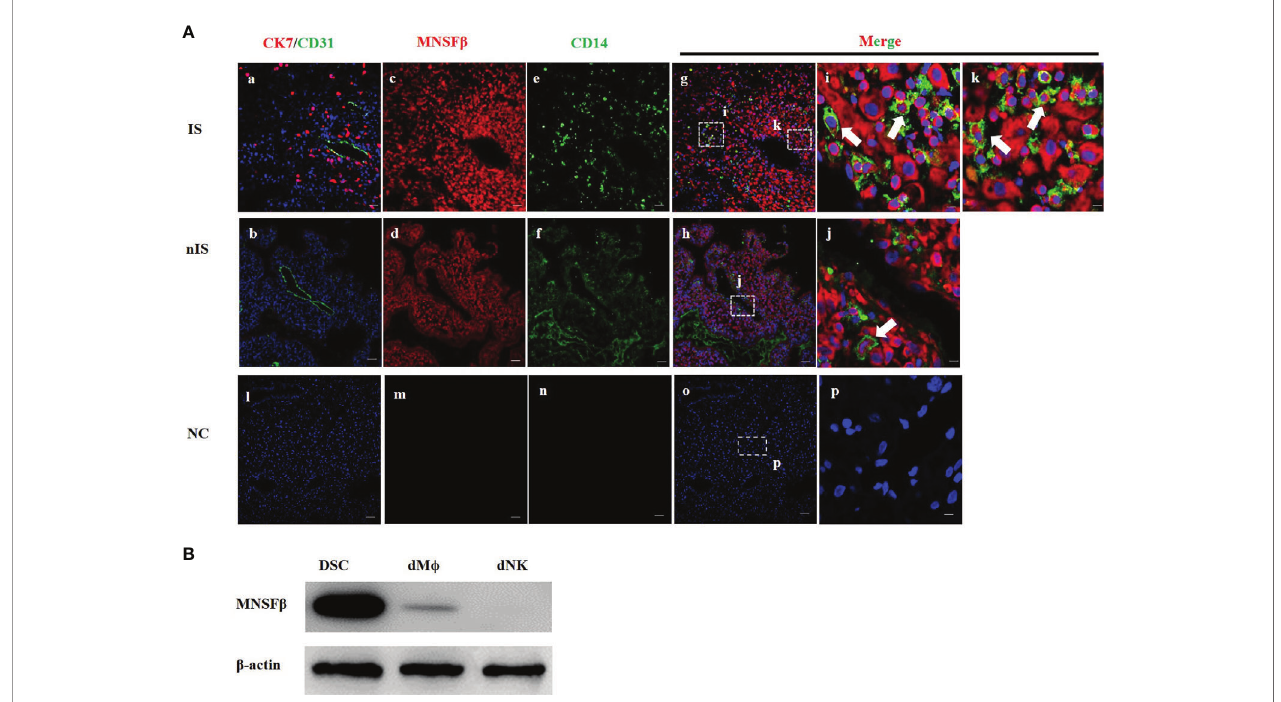
FIGURE 1 | Expression of MNSF b at the maternal – fetal interface. (A) Distribution of MNSF b expression in human decidual tissues of a physically normal pregnant woman in the fi rst trimester (8W) as determined by immuno fl uorescent staining analysis. (a, b) Staining of CK7 (red, marker of trophoblast cells) and CD31 (green, marker of endothelial cells) to con fi rm the embryo implantation site (IS) and nonimplantation site (nIS), and the cell nucleus was stained blue. (c, d) Staining of MNSF b (red). (e, f) Staining of CD14 (green, marker of macrophages). (g, h) Staining of MNSF b (red) and CD14 (green), and the nucleus was stained blue. (i, k) Magni fi cation of images in panel (g) , (j) Magni fi cation of images in panel (h) . (l – p) NC (negative control) of CK7/CD31, MNSF b , and CD14. White arrow indicates typical positive cells. Scale bars of a – h represent 100 m m; scale bars of i – k represent 10 m m. (B) Detection of the MNSFb protein expression in human decidual stromal cells (DSCs), decidual macrophages (dM Ф ), and decidual NK cells (dNKs) of early pregnancy by Western blot